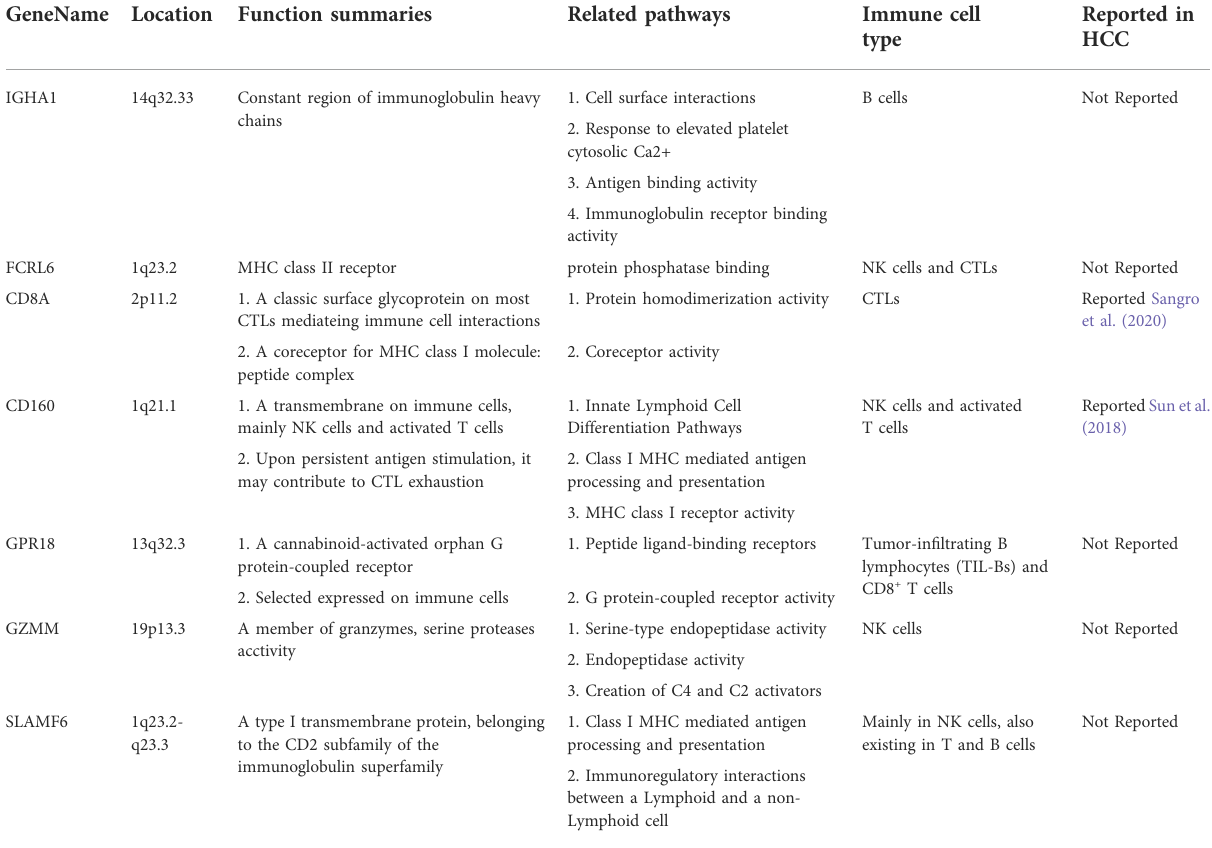
TABLE 6 Summary for immune cell markers. GeneName Location Function